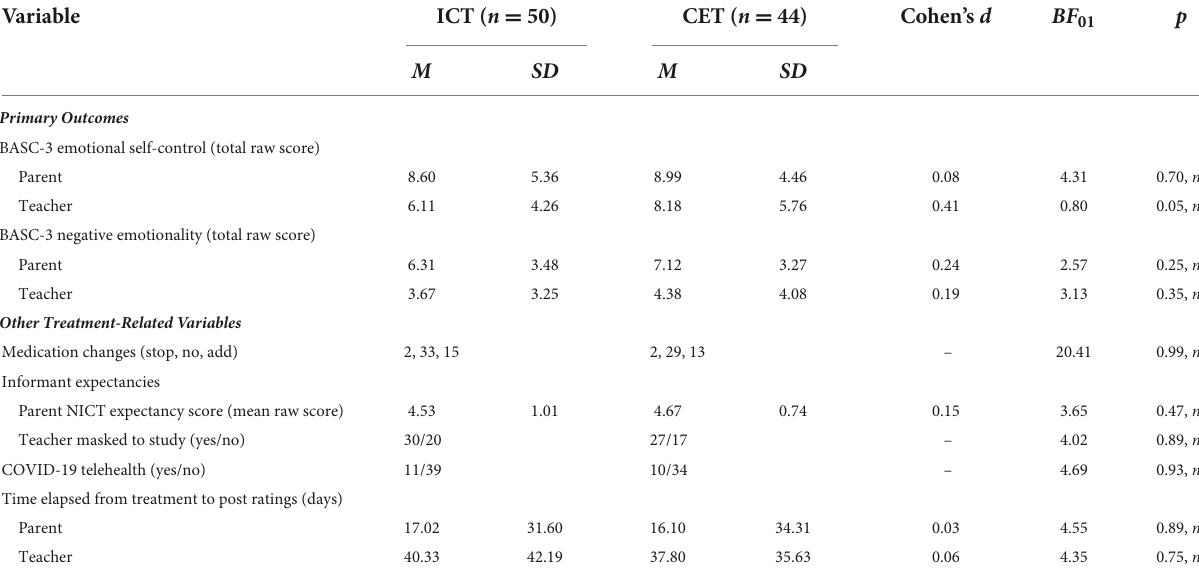
TABLE 3 Post-treatment outcome data and covariates for exploratory analyses.